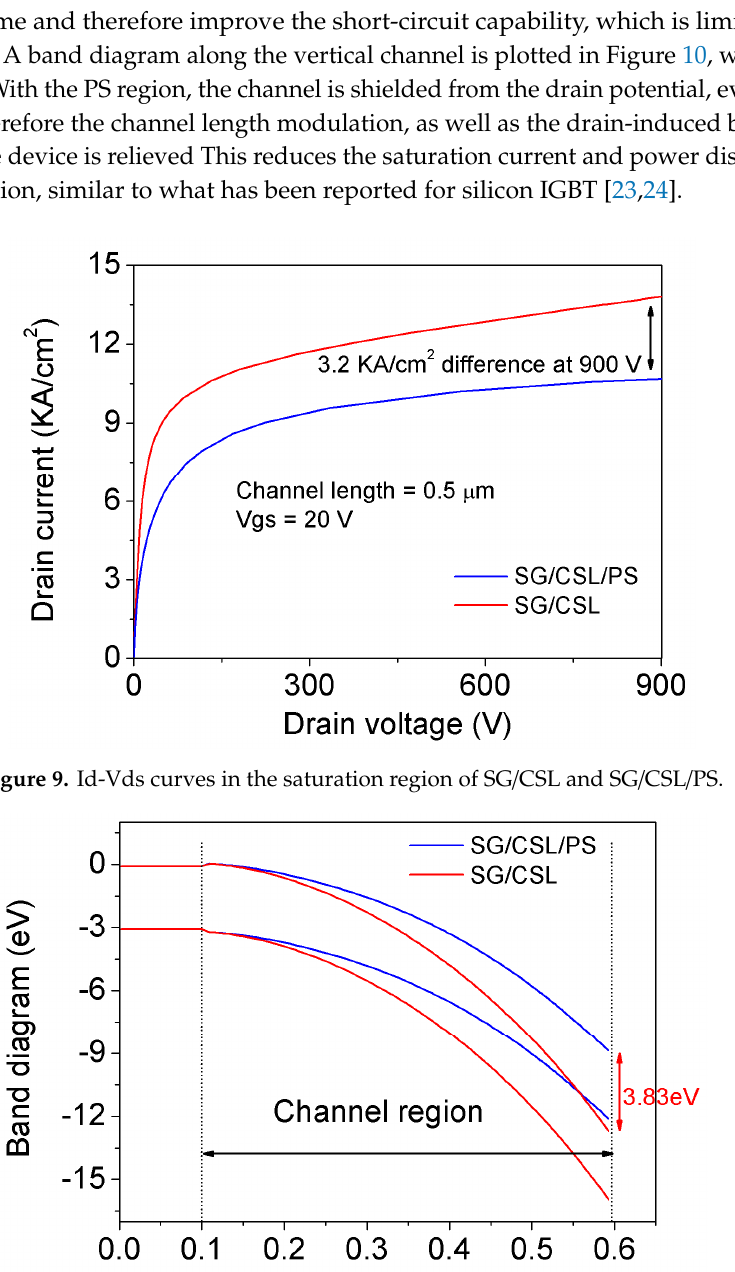
/ CSL and SG / CSL / PS when Vgs = 20 V and Vds = 900 Figure 10. Energy band diagram of SG/CSL and SG/CSL/PS when Vgs = 20 V and Vds = 900 V. Figure 10. Energy band diagram of SG